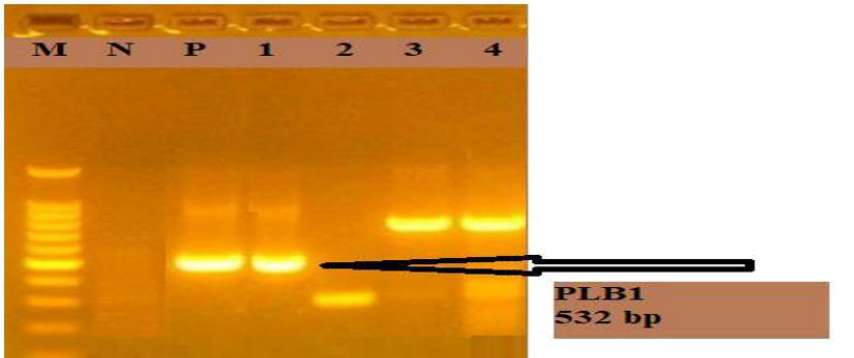
Fig. 8. Agarose gel electrophoresis of 532 bp specific PCR product for PLB1 gene for Cryptococcus spp.using 1.5% agarose gel at 90V for 1hr. in 1x TBE buffer, and visualized under transilluminator UV after staining by ethidium bromide. Lane M: 100 bp DNA ladder, lane (1): positive result, lane N: negative control and lane P: positive